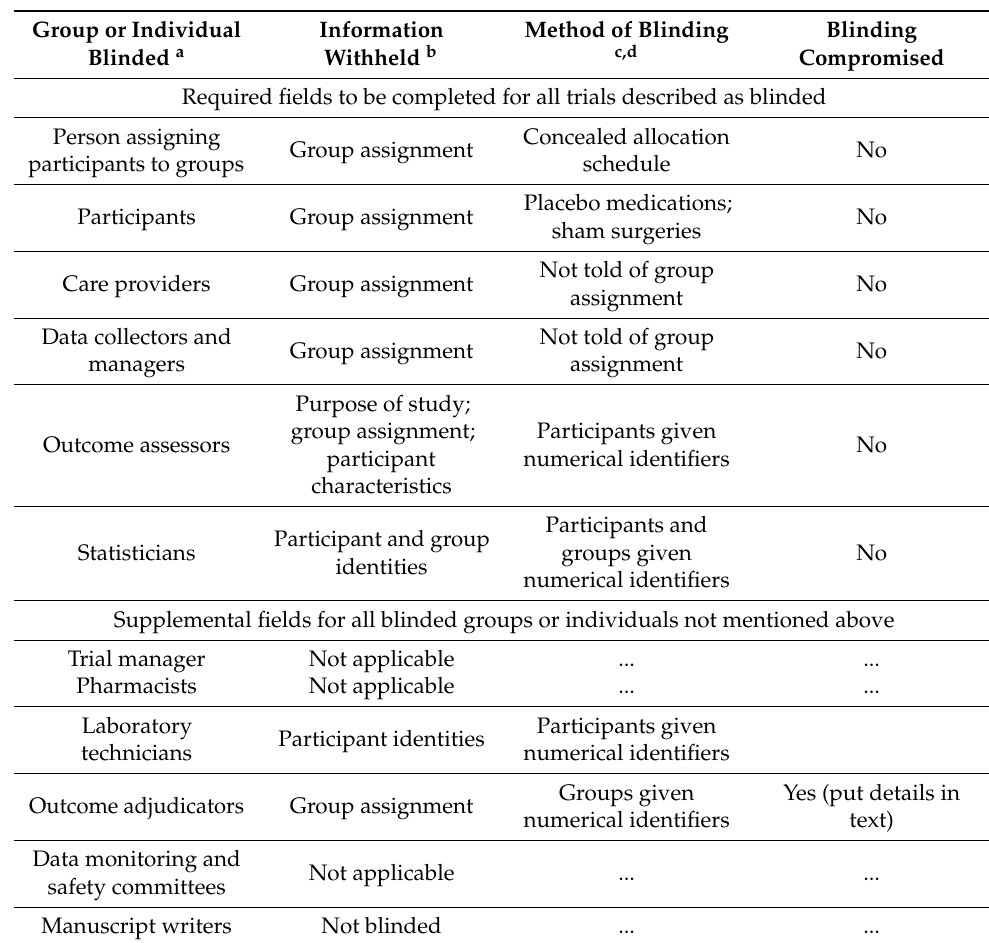
Table 1. A standard table for reporting the use of blinding in randomized trials of pharmaceutical